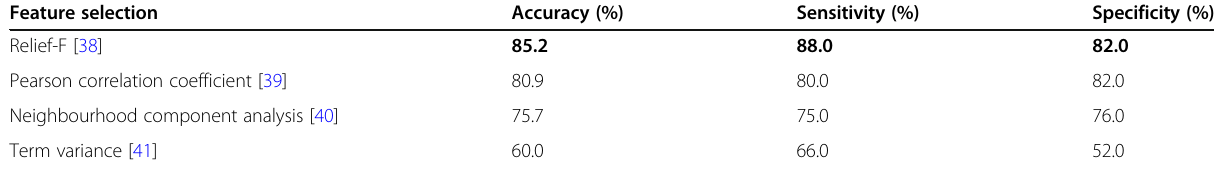
Table 9 Classification results obtained using the top 20 features selected by four different feature selection algorithms